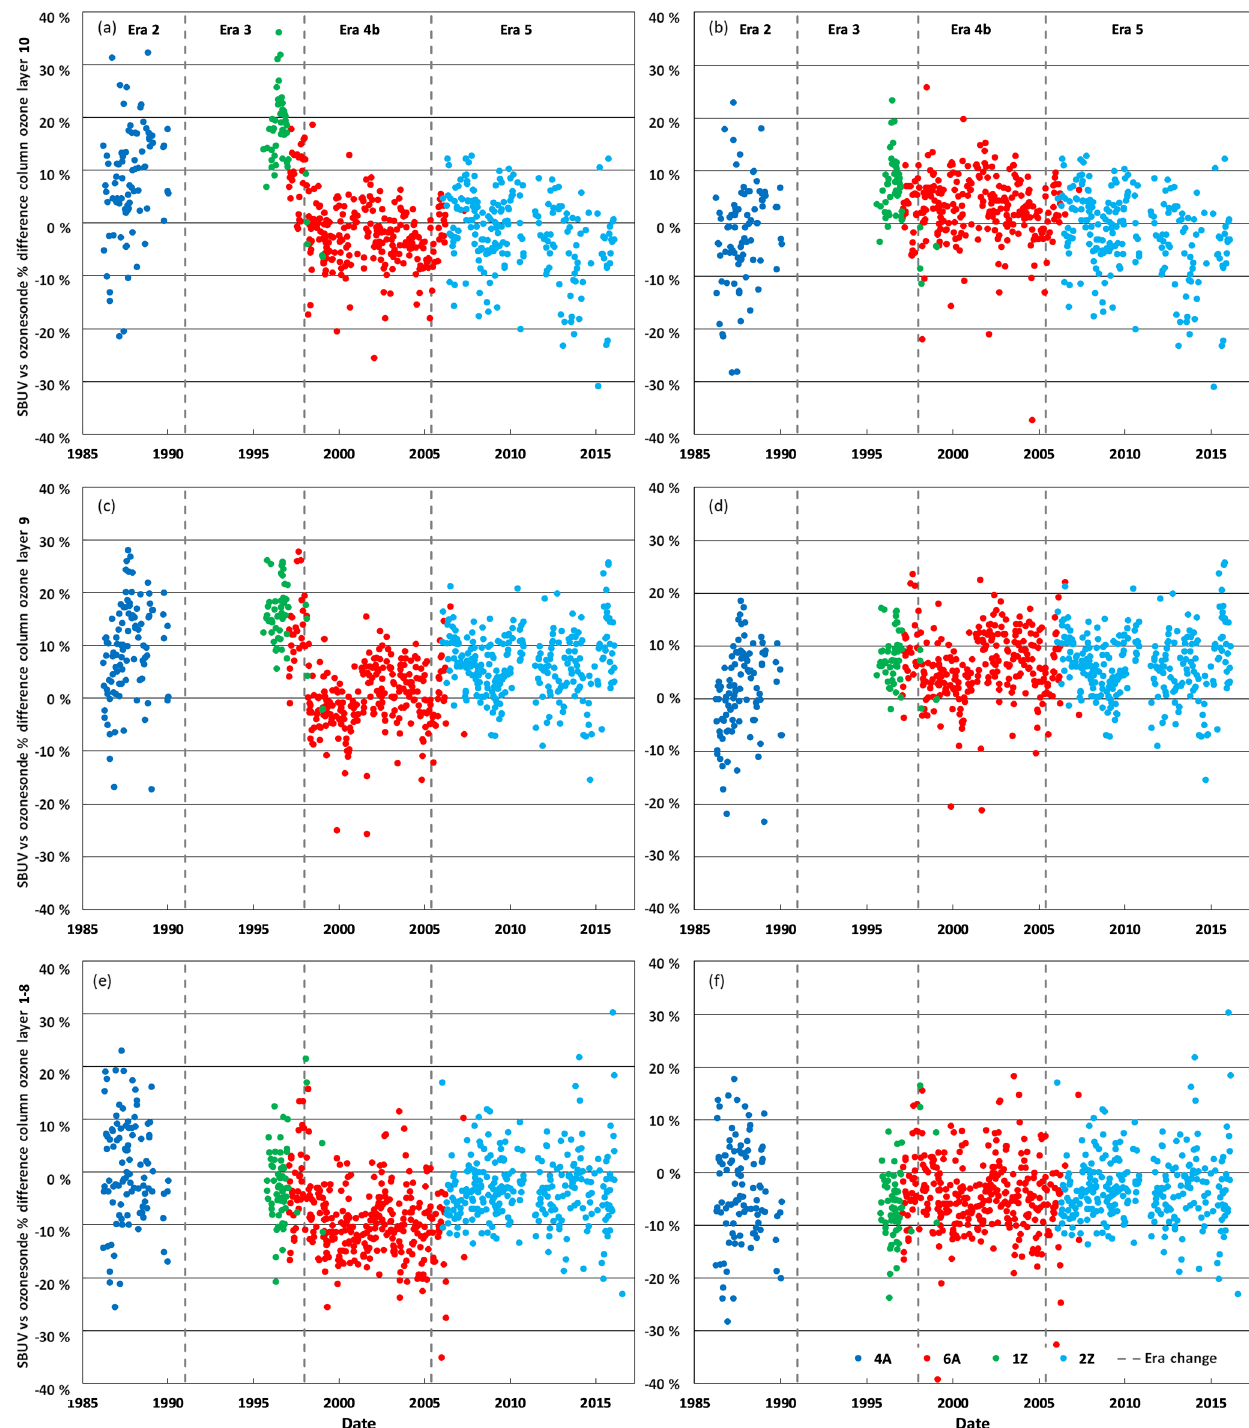
Figure 15. Percent difference in column ozone between the merged SBUV ozone data and the ozonesonde data at Pago Pago, American Samoa. Panels (e) and (f) show Layers 1–8 (surface–25.45hPa), panels (c) and (d) show Layer 9 (25.45–16.06hPa), and panels (a) and (b) show Layer 10 (10.13–16.06hPa). Panels (a) , (c) , and (e) show before and panels (b) , (d) , and (f) show after applying the ozone sensor